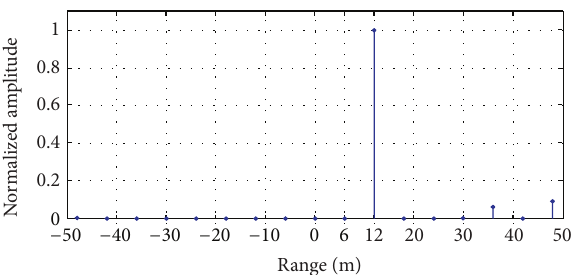
Figure 12: Retrieved signal peaks with the target placed at 12m.